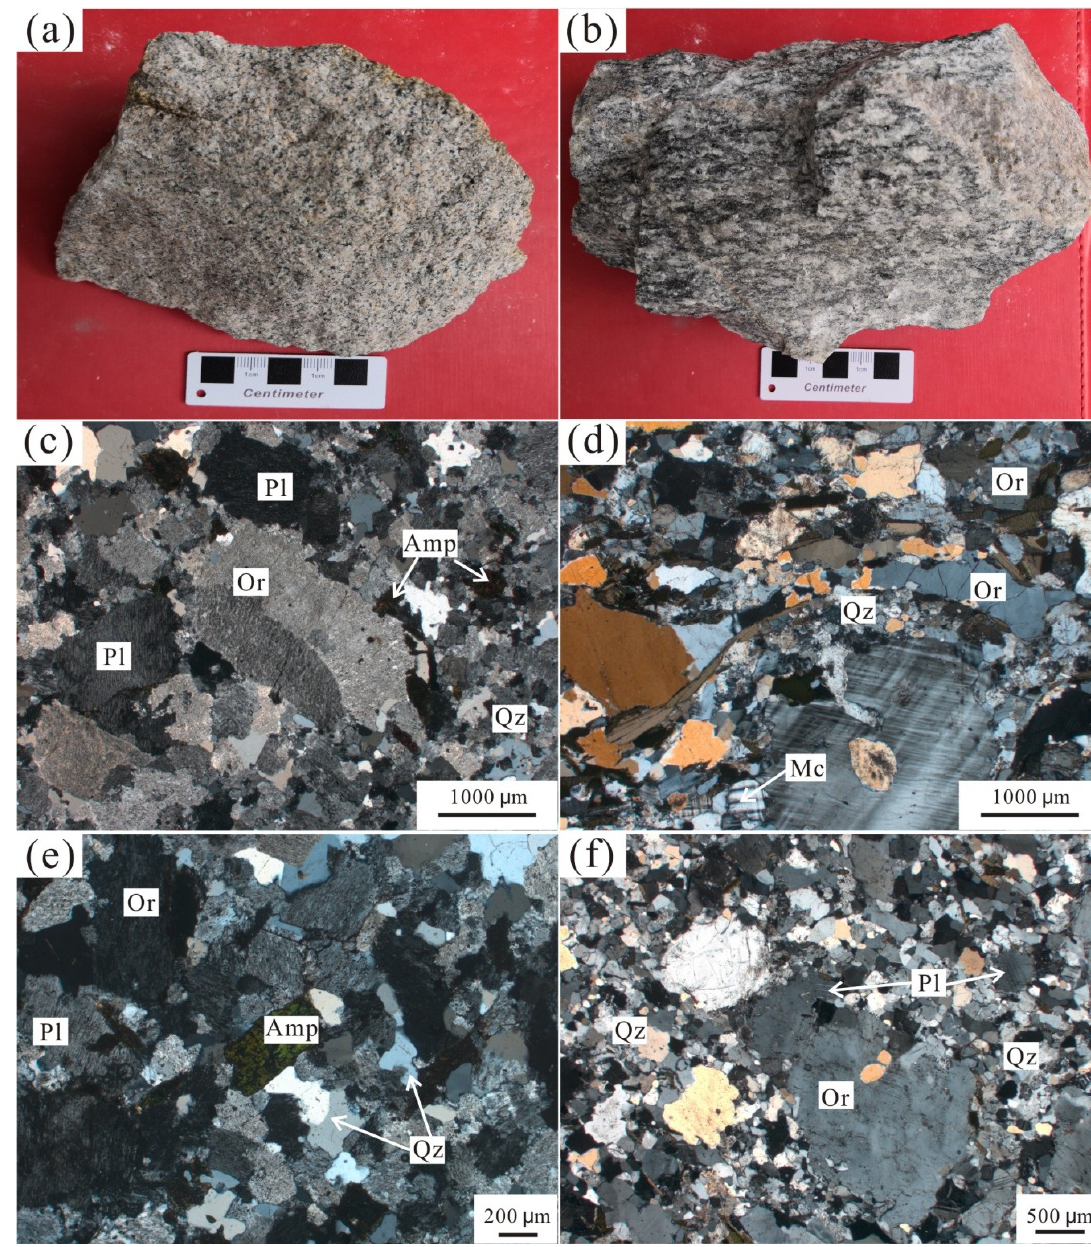
Figure 3. Petro-mineralogical diagram of the Chishan alkaline complex: ( a ) Quartz syenite; ( b ) alkali granite; ( c ) Carlsbad twins of the syenite; ( d ) crosshatch twins of the microcline; ( e ) hornblende occuring in columnar form; ( f ) quartz occurs interstitially between the feldspar grains. The (c) and (e) photos under the microscope refer to the sample present in (a); the (d) and (f) photos under the microscope refer to the sample present in (b). Qz-quartz; Or-orthoclase; Pl-plagioclase; Amp-amphibole; Mc-microcline.